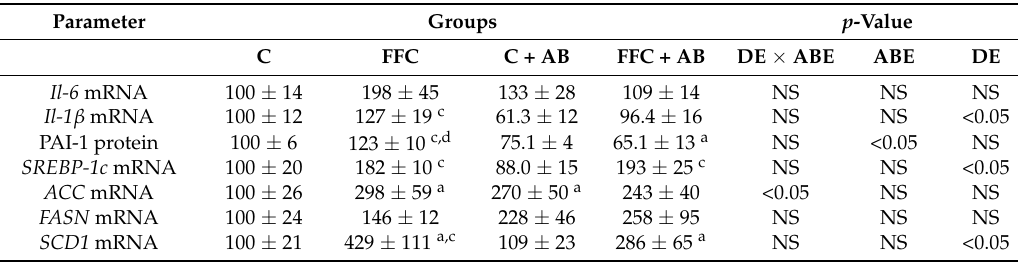
Table 3. Effect of the short-term feeding of a FFC or control diet ± antibiotic treatment on markers of inflammation and lipogenesis in liver tissue. Parameter PAI-1 protein